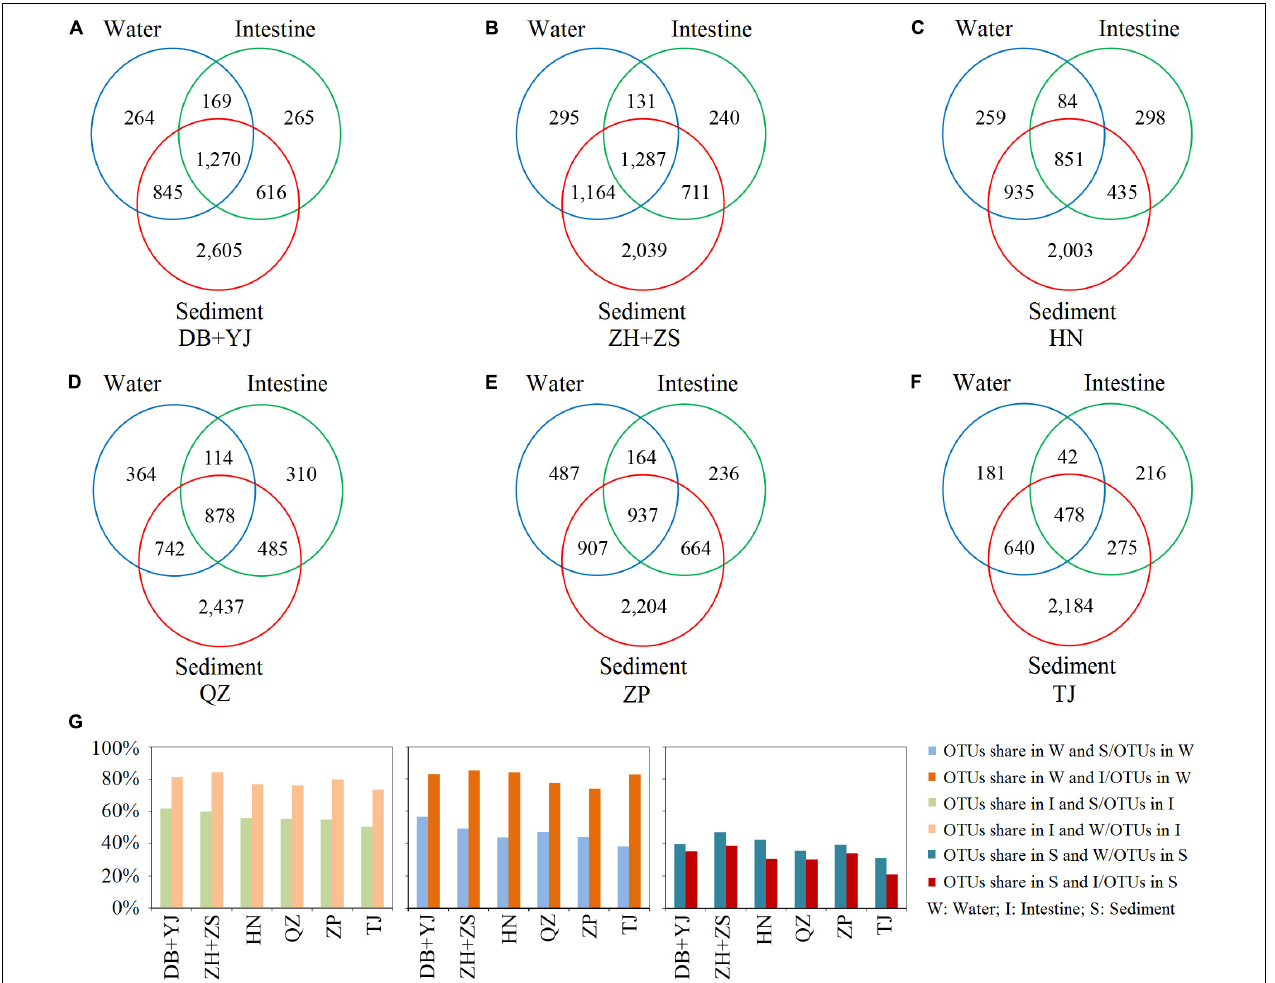
FIGURE 2 | Venn analysis of microbial composition in water, shrimp intestine, and sediment habitats based on detected OTUs of six regions. (A–F) The numbers of OTUs in each habitat and shared in any two or three habitats. (G) The percentage of OTUs shared in any two